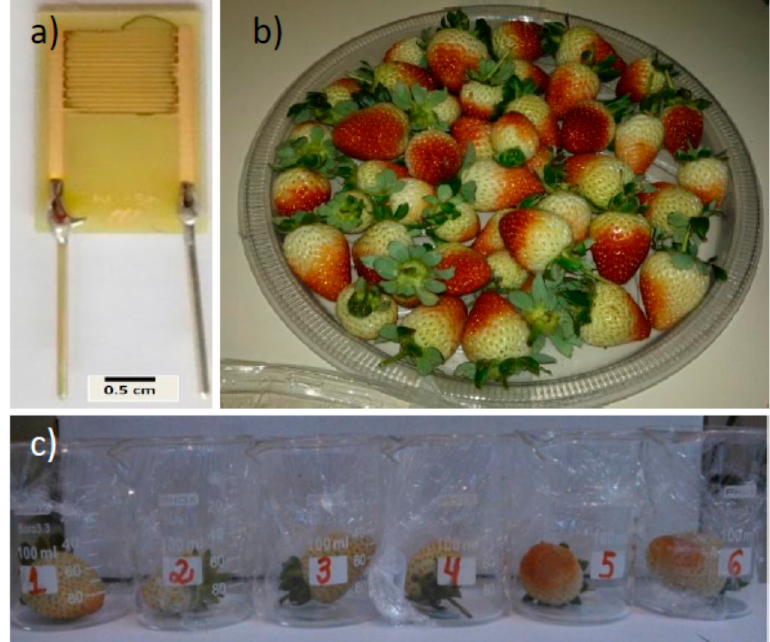
Figure 1. ( a ) Interdigitated electrodes with multi-walled carbon nanotubes (MWCNTs) film; ( b ) green strawberries; and ( c ) strawberries inoculated with Aspergillus .